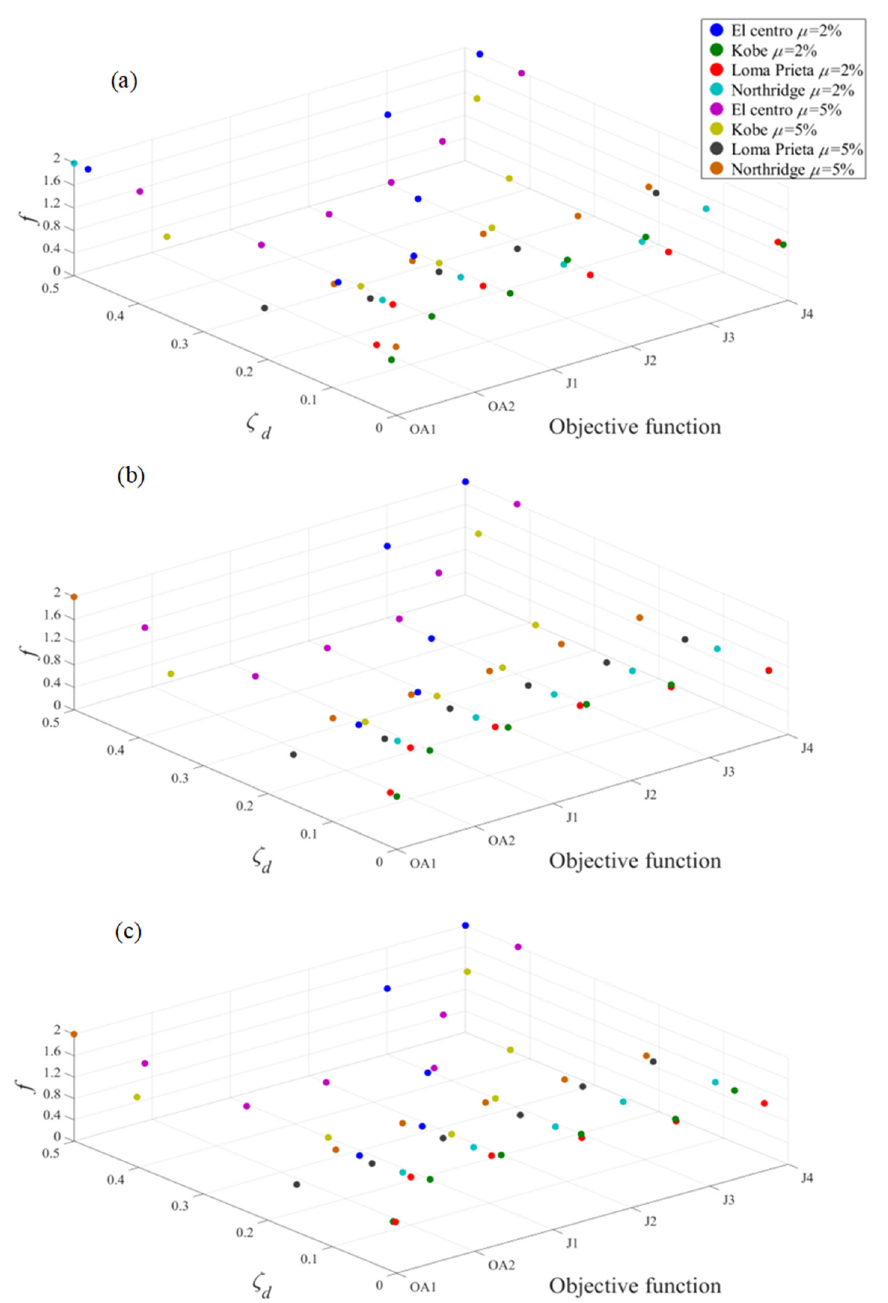
Figure 4. Scatter graphs for TMD design parameters: ( a ) DE; ( b ) ES; ( c )